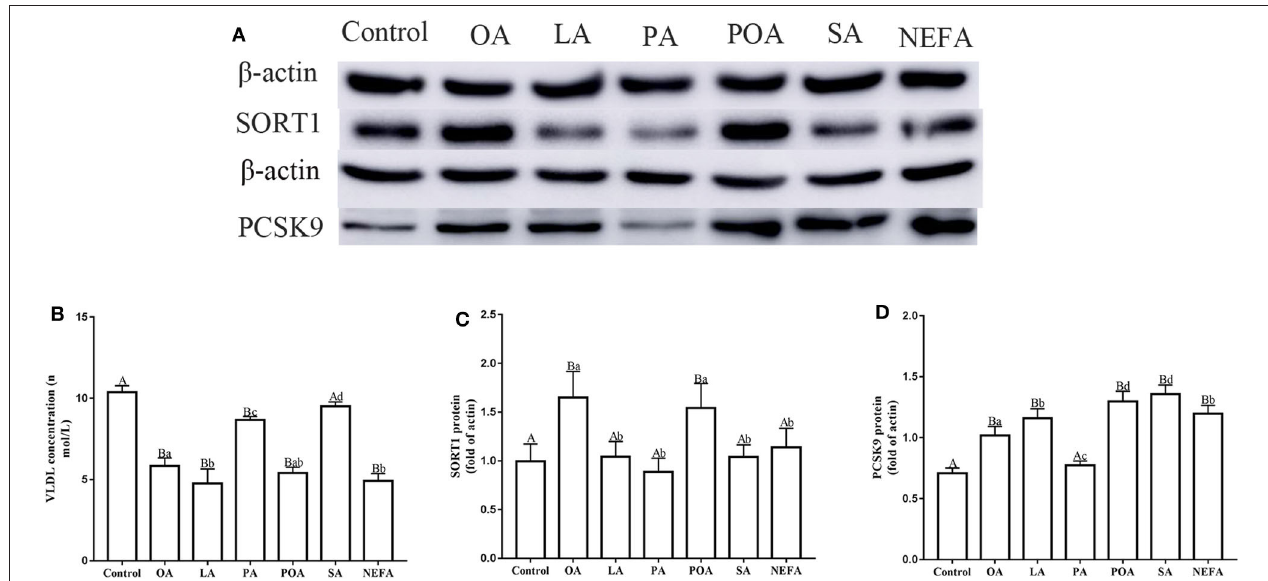
FIGURE 4 | Effects of different fatty acids on the assembly and synthesis of VLDL in primary hepatocytes. Cells were treated with 1.2 m M fatty acids for 12h ( n = 3 ell preparations). (A) β -actin, SORT1, and PCSK9 protein expression were assayed by western blotting. Gray-shaded bars represent the amount (%) of β -actin, SORT1, and PCSK9 protein in primary hepatocytes. (B) VLDL concentration was determined by ELISA. (C,D) SORT1 and PCSK9 expression were reported relative to that of β -actin. Data are means ± SEM. Each assay was performed in triplicate. Uppercase letter vs. control p ≤ 0.05, lowercase letter vs. fatty acid group p ≤ 0.05, and same letter vs. no letter mark p ≥